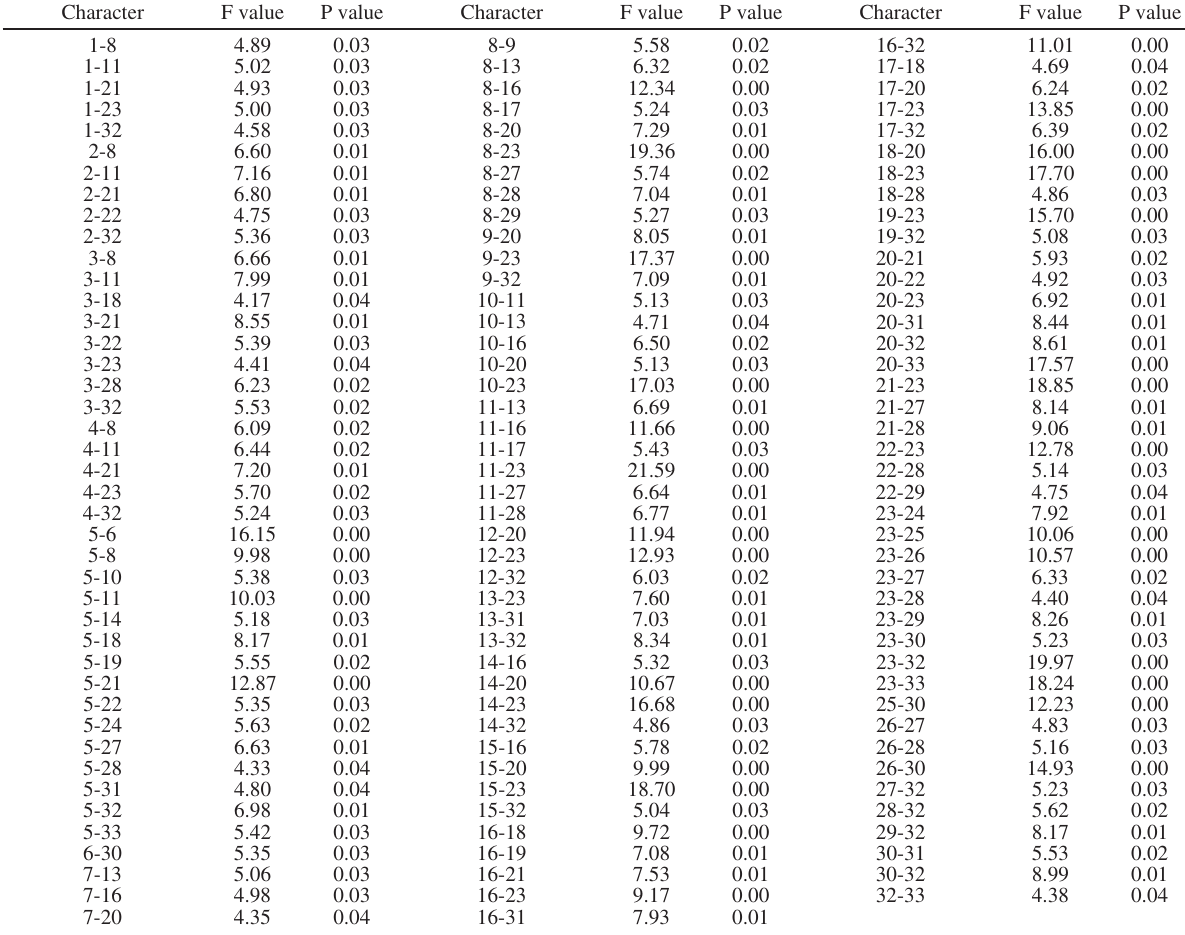
Table 1. – Significant results of ANOVA for morphometric character of the body shape of juvenile Persian sturgeon ( Acipenser persicus ) as described by landmarks collected from the western and eastern Iranian coastal water of the Caspian Sea between October 2012 and June 2015. P is regarded as being significant if <0.05